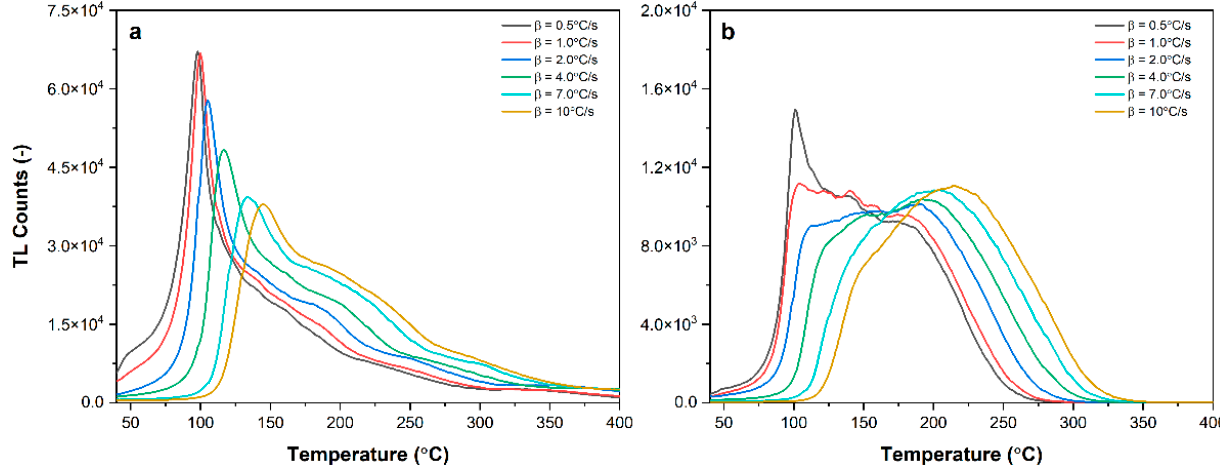
Figure 9. TL glow curves of PPG ( a ) and terbium-doped phosphate glass ( b ), PPG_Tb05) measured at various heating rates (irradiation dose ca. 10 kGy, terbium-doped glass measured using shutter reducing light intensity ca. 100×).